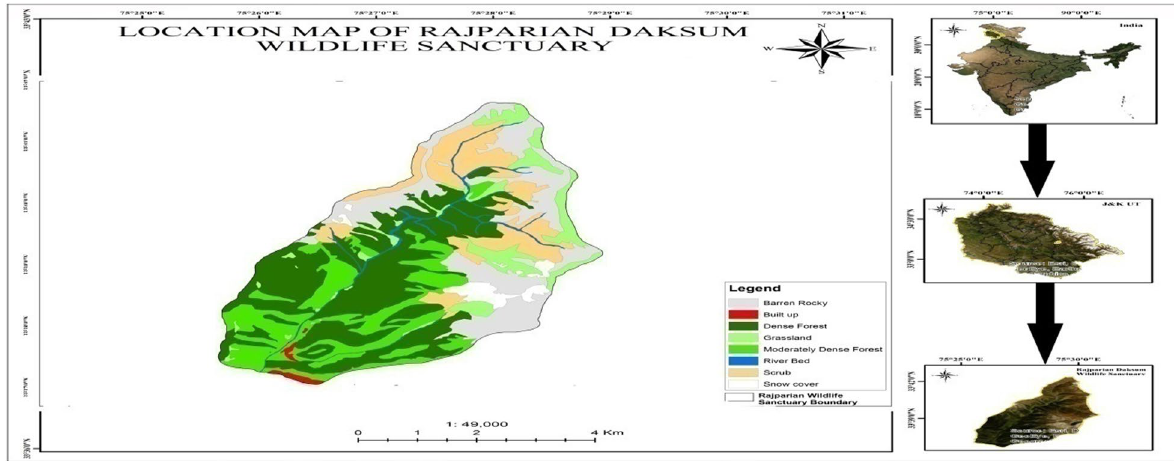
Fig. 1 Map of the study area showing different land